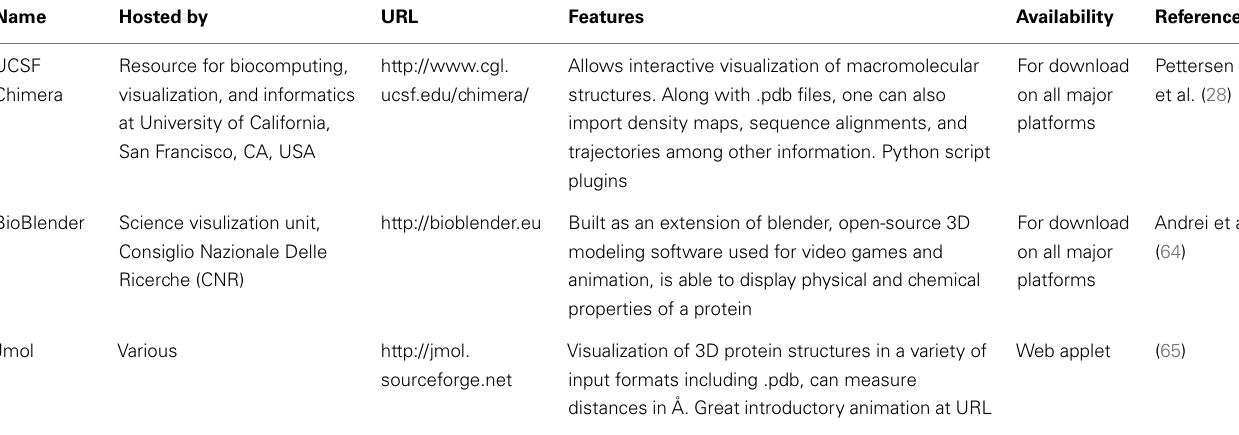
Table 3 | Summary of publicly available software for the modeling of macromolecular structures .